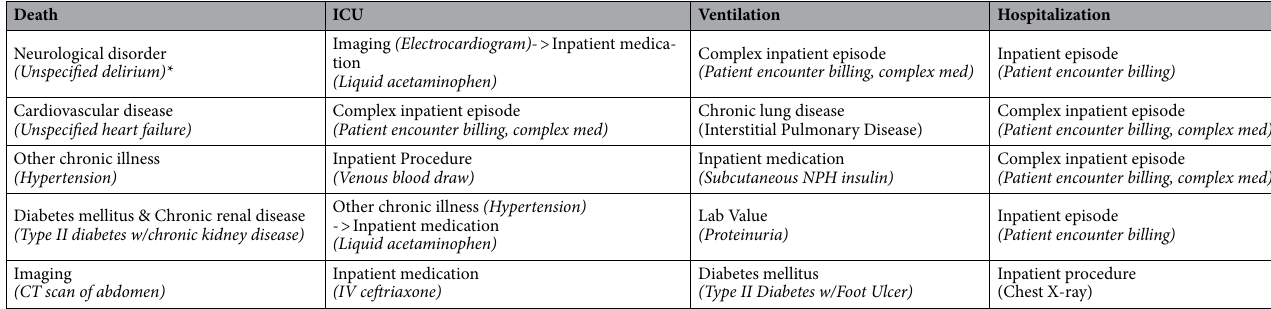
Table 2. The top five ranked features from the clinical records that are associated with death, ICU admission, mechanical ventilation, and hospitalization. *Parentheses below each of the interpreted terms include a shorthand version of the actual